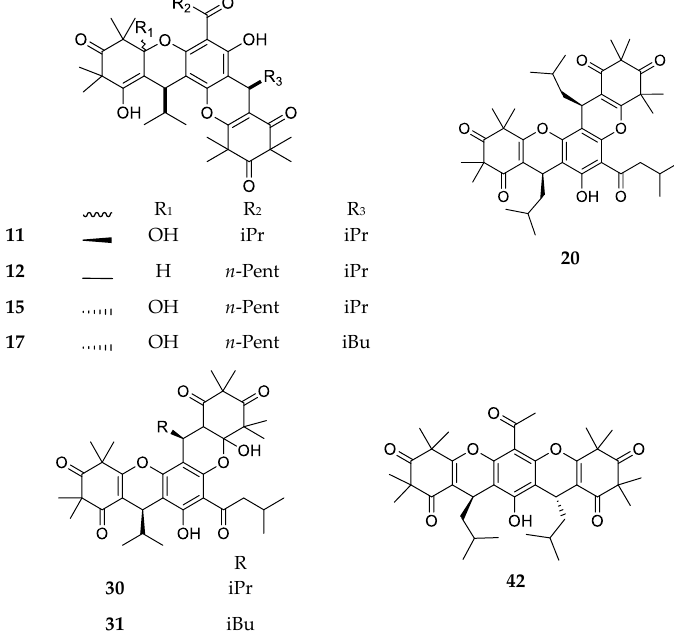
Figure 5. Structures of compounds of the trimeric-dipyrane type.